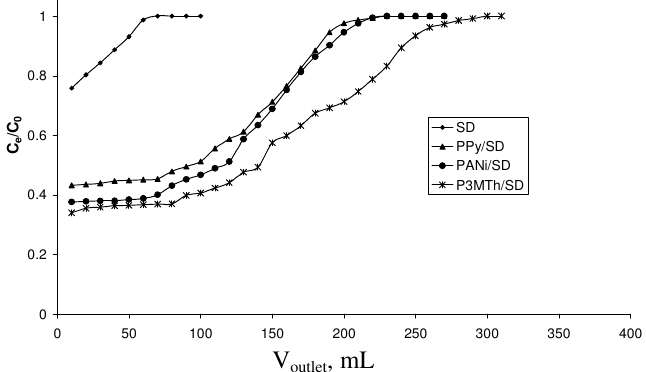
Figure 9. Breakthrough curves obtained for SD, PPy/SD, PANi/SD and